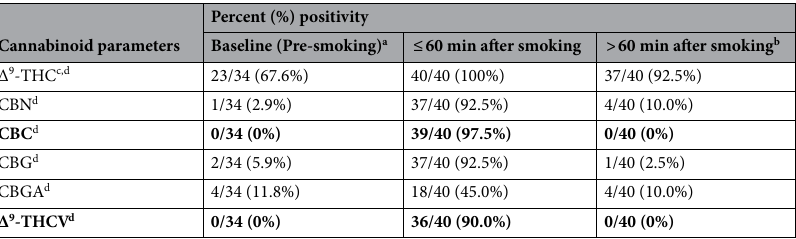
Table 5. Presence of key cannabinoids in exhaled breath before and after smoking. a Pre-smoking samples were not collected from 10 subjects. b No data beyond 60 min post-smoking in 4 subjects. c Although ∆ 9 -THC was not detected in approximately one-third of subjects prior to smoking, other indicators of prior cannabis use, e.g., ∆ 9 -THCA, were detected at baseline in all subjects. d For CBN, CBC, CBG, CBGA, and ∆ 9 -THCV, percent positivity differences were significant ( P < 0.01) when comparing baseline to ≤ 60 min post-smoking and ≤ 60 min post-smoking to > 60 min post-smoking. For ∆ 9 -THC, the percent positivity differences were significant ( P < 0.01) when comparing baseline to ≤ 60 min and > 60 min